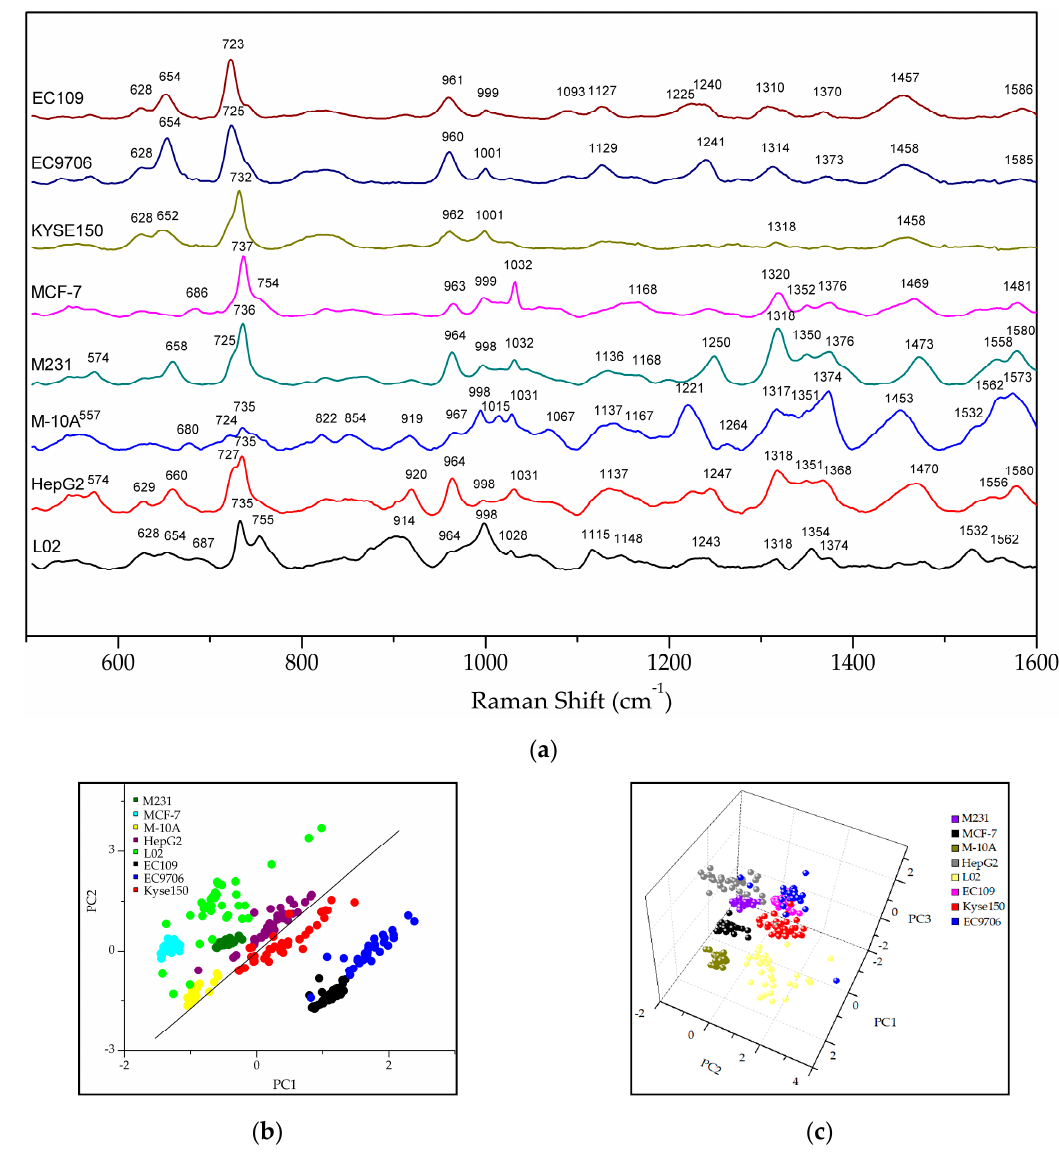
Figure 3. The Raman phenotypes of exosomes derived from eight di ff erent cell types. ( a ) Exo-SERS acquired from EC109, EC9706, Kyse150, MCF-7, M231, M-10A, HepG2 and L02 cells; ( b ) The two-dimensional scatter plot of PC1 (48.98%) and PC2 (23.49%) showed that the esophageal cancer cell-derived exosomes were absolutely distinguished from other cell derived exosomes by selecting the 600–760 cm − 1 region; ( c ) Three-dimensional scatter plot of PC1 (50.03%), PC2 (12.24%) and PC3 (8.12%) showed that the breast cell-derived exosomes were absolutely distinguished from other cell derived exosomes by selecting the 940–1100 cm − 1